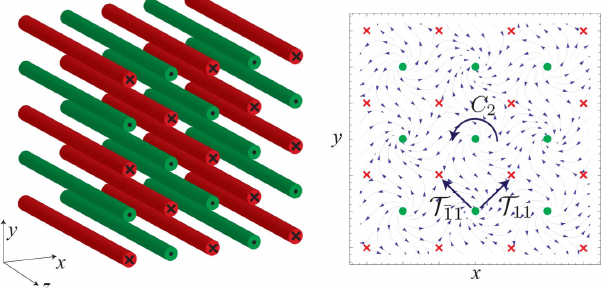
FIG. 5. (Left) A 3D array of Dirac strings. (Right) Cross section of the array. associates into-the-plane Dirac channel, repre- sents out-of-plane ones. Stream lines represent the configuration of the mass-parameter vector field m ð r Þ ¼ ½ m vortex lattice.